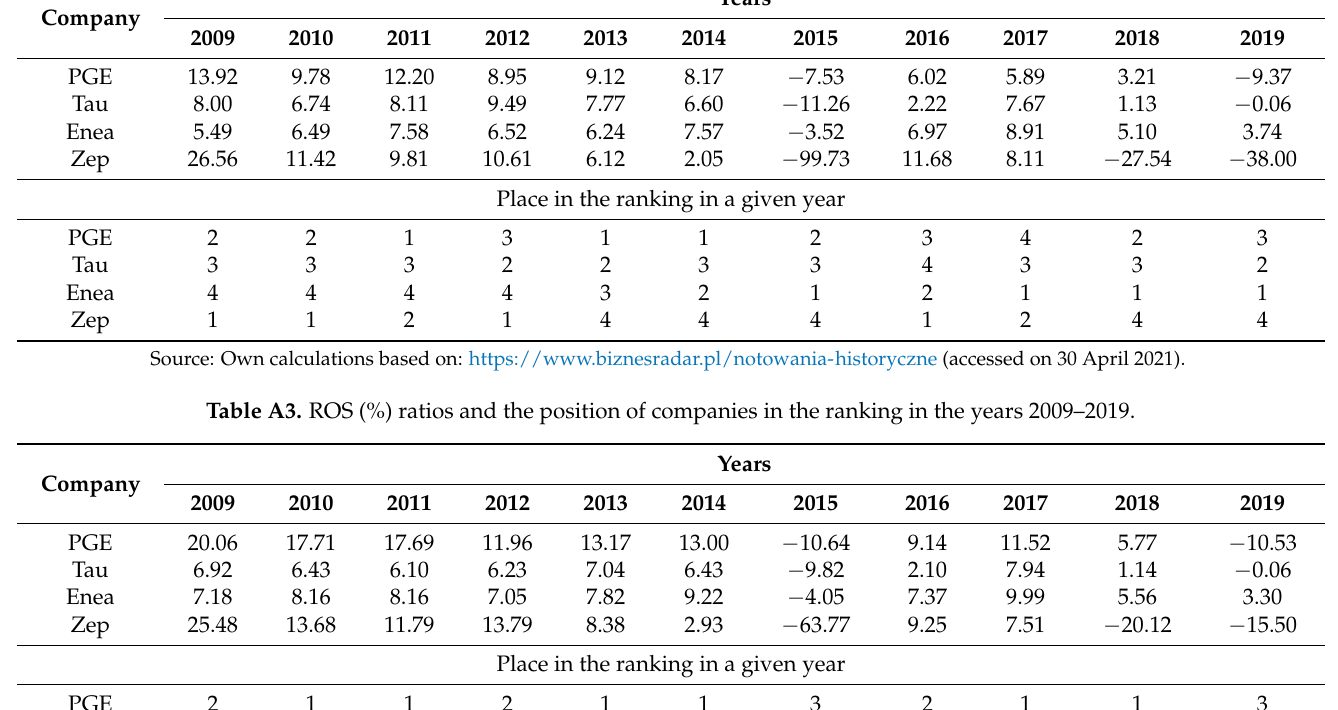
Table A2. ROE (%) ratios and the position of companies in the ranking in the years 2009–2019. Company